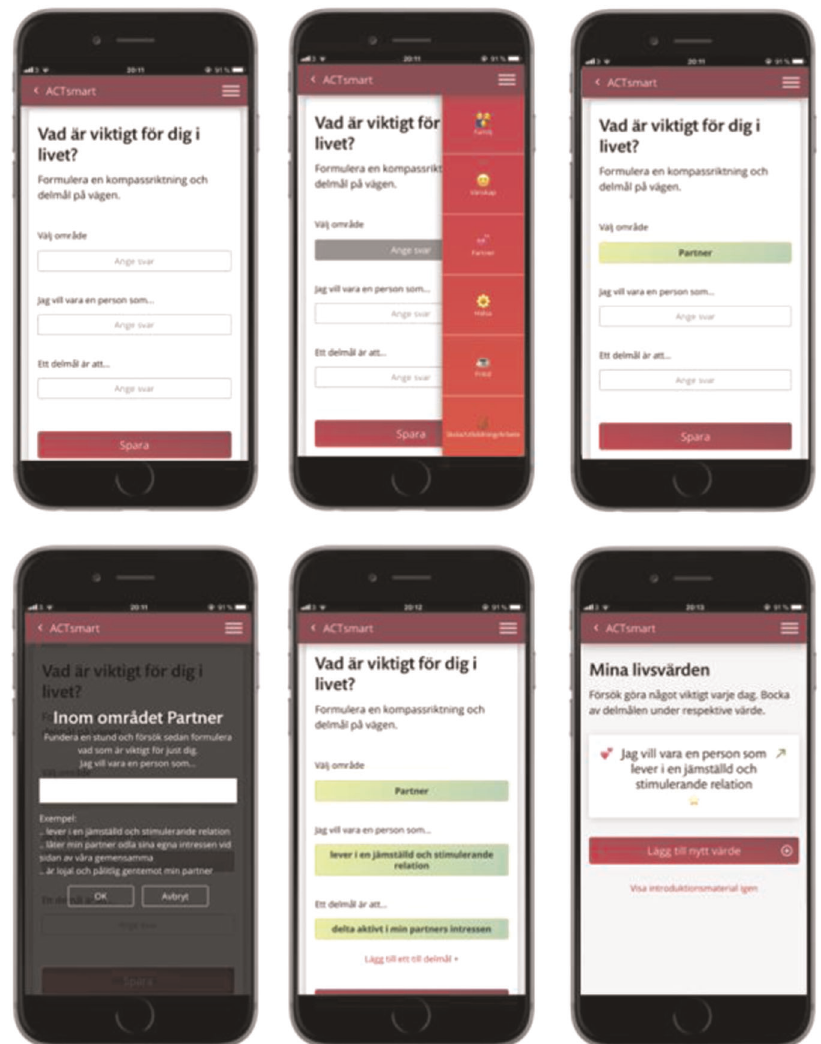
Fig. 5 Each step for formulation of values after iterations based on beta user insights (the native version).